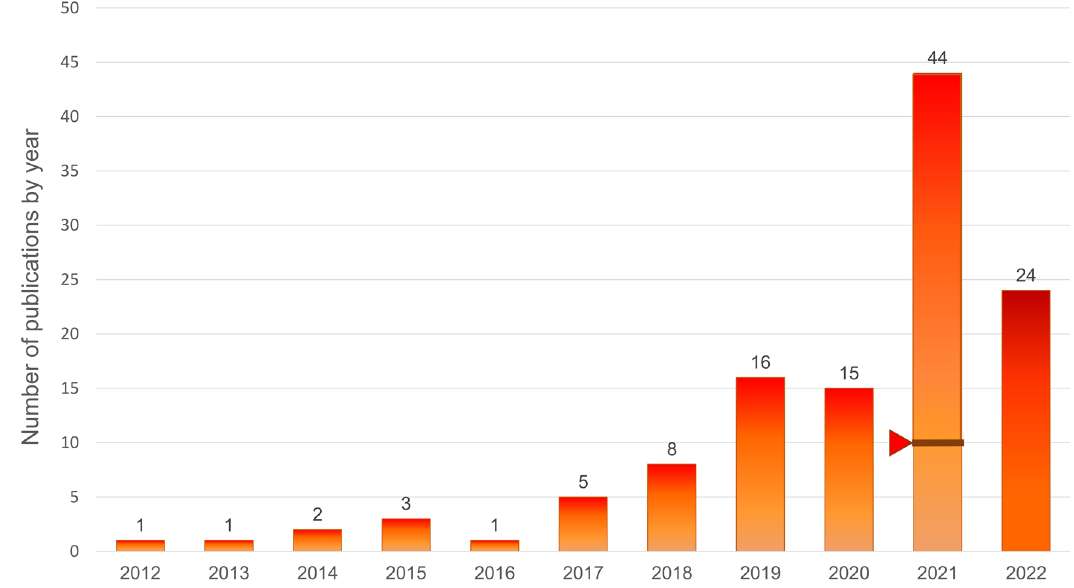
Figure 3: Number of publications related to waste - derived graphene nanocomposites in the past decade.